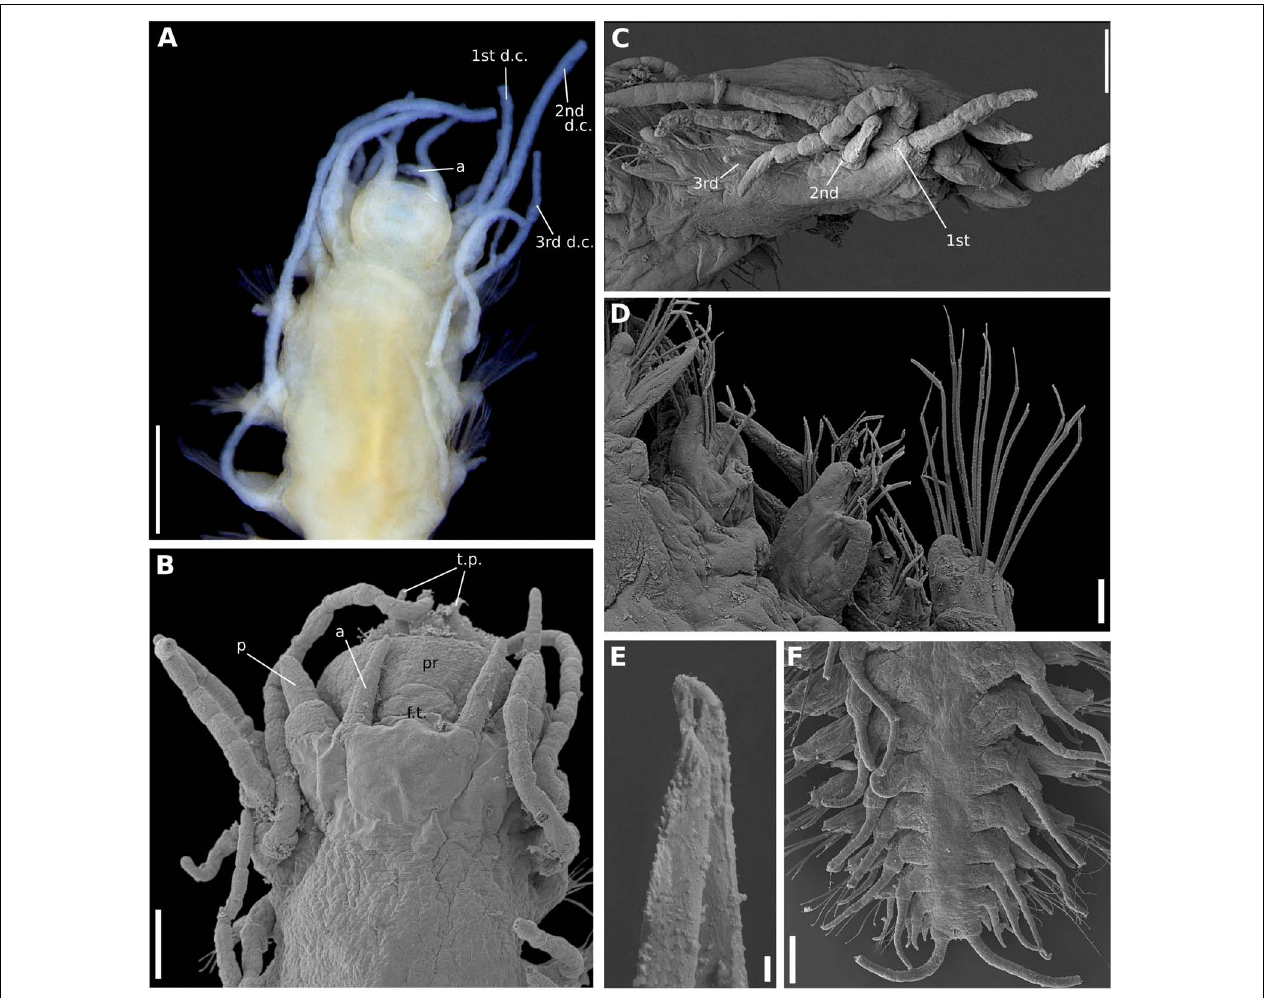
FIGURE 9 | (A–F) Sirsoe yokosuka sp. nov. (A) anterior end, dorsal view; (B) anterior end, dorsal view; (C) anterior end, lateral view; (D) median neuropodia, ventral view; (E) detail of neurochaeta; (F) posterior end, dorsal view. 1st d.c., first dorsal cirrus; 2nd d.c., second dorsal cirrus; 3rd d.c., third dorsal cirrus; a, lateral antenna; ci, ciliation; d.c, dorsal cirri; f.t, frontal tubercle; p, palps; p.c, pygidial cirri; p.p, pygidial papilla; t.p, terminal papilla; v.c, ventral cirri. Numbers in (C) referring to the segment. Scales: (A) 200 µ m; (B,F) 100 µ m; (C) 20 µ m; (D) 40 µ m; (E) 2 µ m.